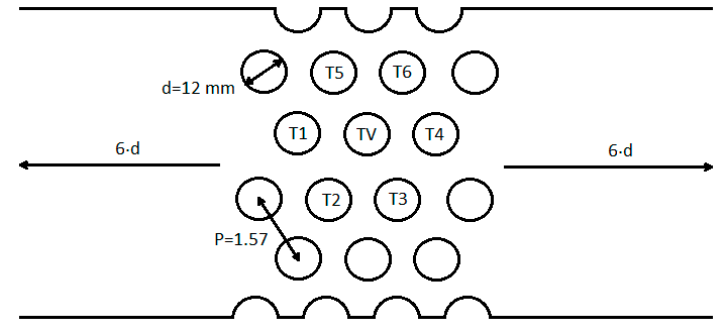
Figure 1. Parallel triangular tube array configuration and geometrical parameters used in the study.